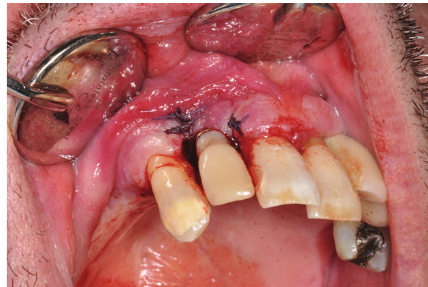
Figure 5: Suture of the surgical wound.